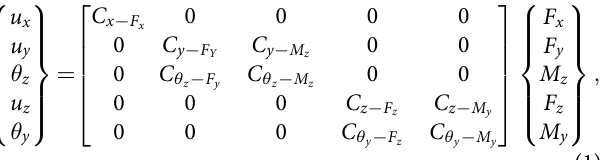
TABLE 1 | Comparison of piezoelectric stack actuators from NOLIAC . Size (mm) Free stroke (μm) Stiffness, k a (N/ μm) Max. blocking